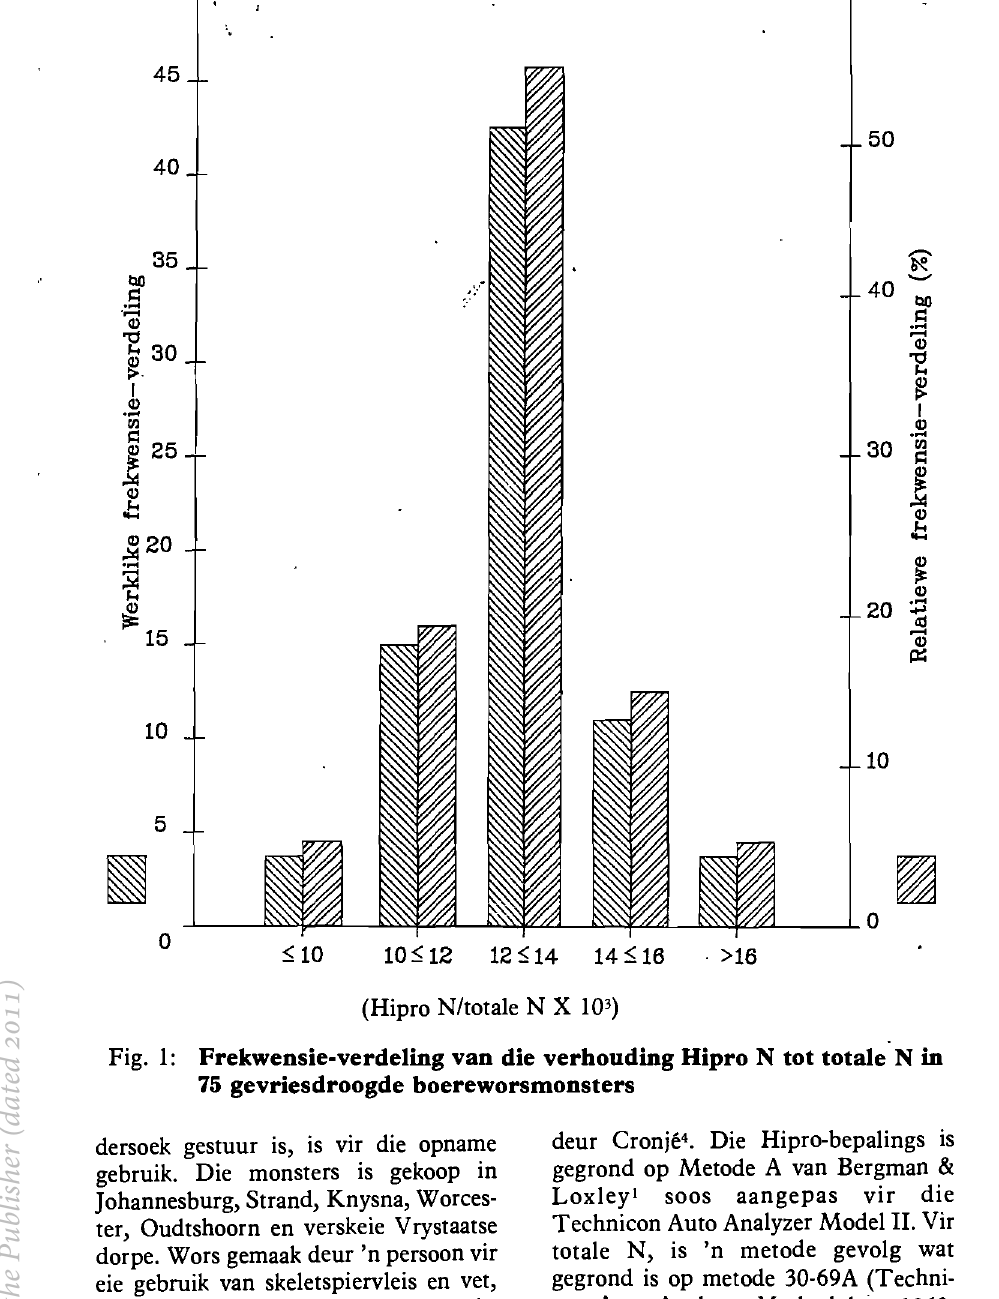
Johannesburg, Strand, Knysna, Worces ter, Oudtshoorn en verskeie Vrystaatse dorpe. Wors gemaak deur 'n persoon vir eie gebruik van skeletspiervleis en vet, derstelling dat die wors van